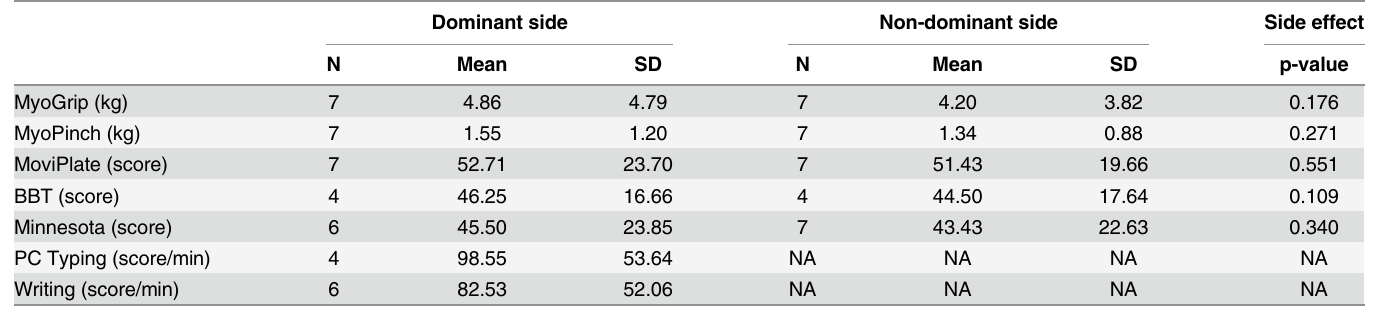
Table 3. Effect of dominance on functional task results.